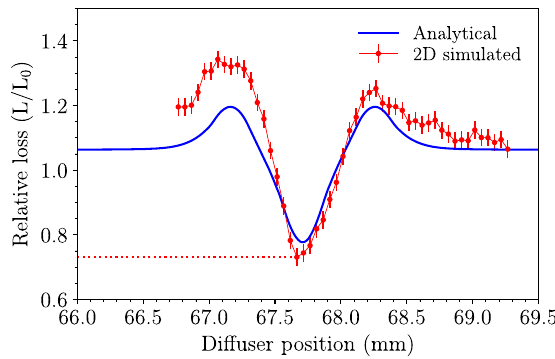
FIG. 16. 2D simulated and analytical relative total loss as a function of the diffuser position, for 550 μ m diffuser width and a length of 5